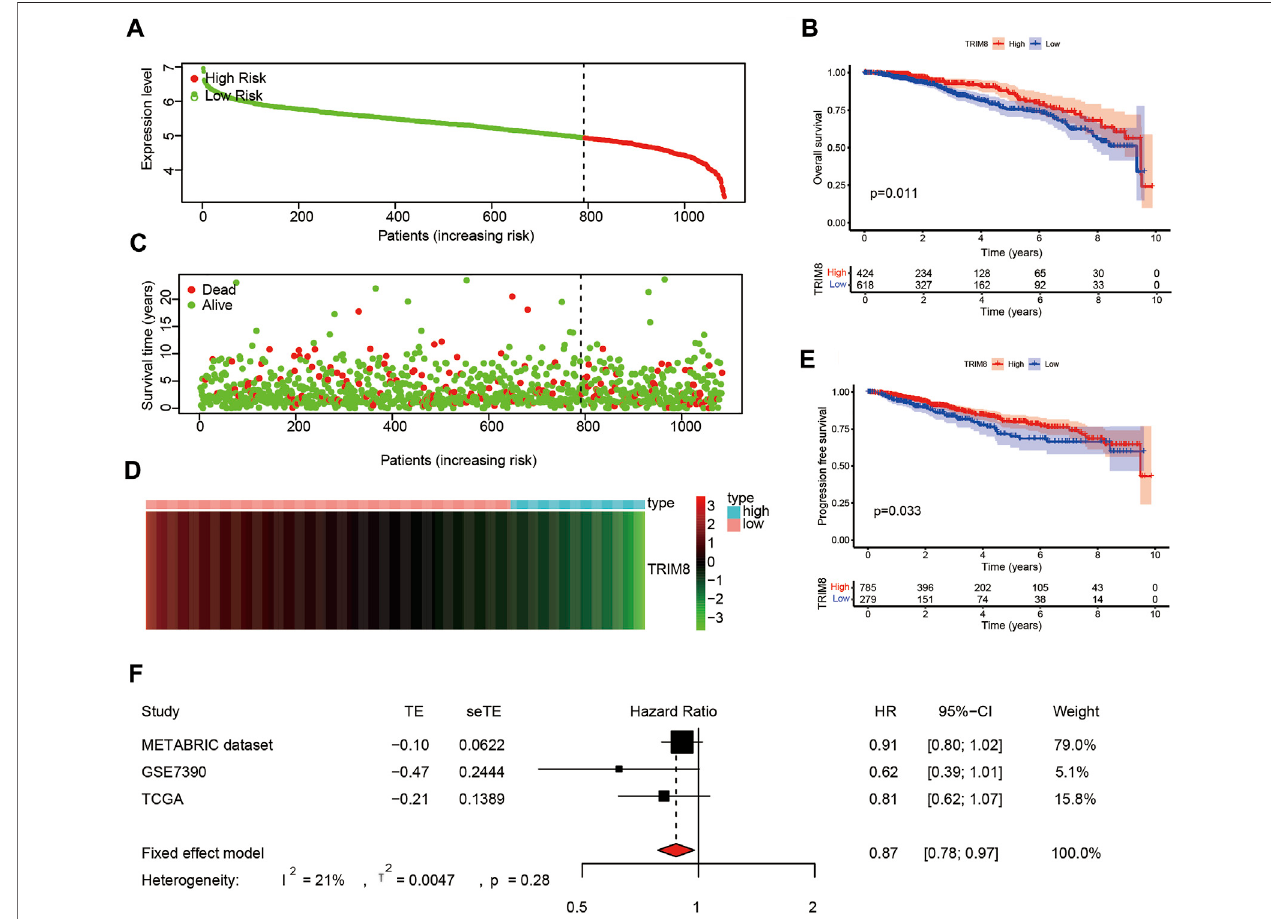
FIGURE 3 | The prognostic value of TRIM8 expression level in breast cancer based on TCGA database (A) Patients with breast cancer strati fi ed into high- expression (low-risk; green line) and low-expression groups (high-risk; red line) using the minimum p -value approach (B) Kaplan ‒ Meier survival curves showed the over survival probability between the high-risk groups and low-risk groups. (C) Survival time and survival status of patients with breast cancer compared between high-risk groups and low-risk groups (setting 10-years as a cut-off). Green plots for alive, red plots for dead (D) Heatmap showed the expression of TRIM8 in different groups. Blue color represented high-risk group, while pink color represented low-risk group. (E) Kaplan – Meier survival curves displayed progression-free survival (PFS) between the high-risk groups and low-risk groups (setting 10-years as a cut-off). (F) Forest plot of high TRIM8 expression with better over survival in breast cancer patients from three